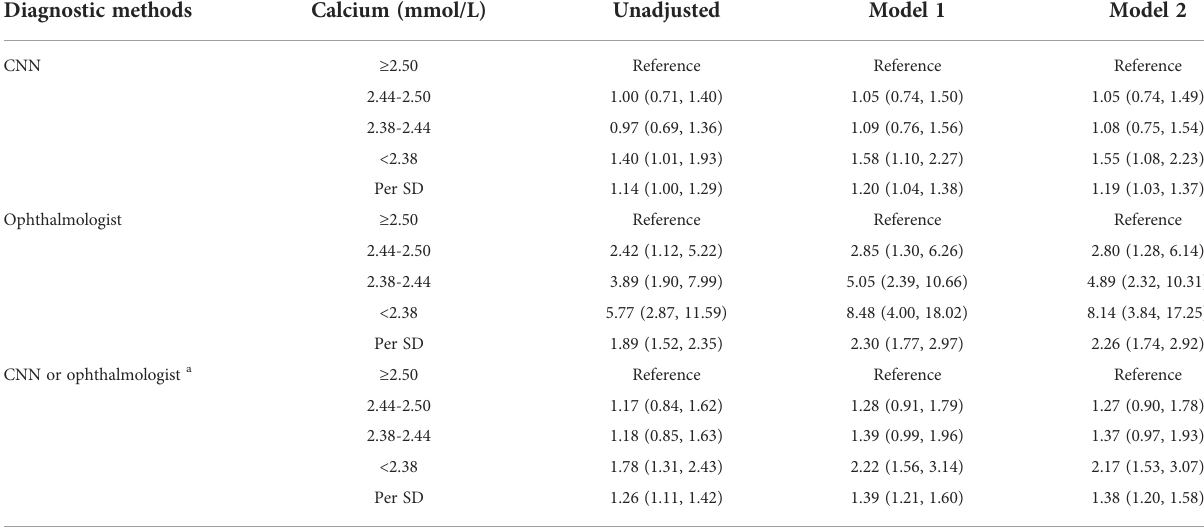
TABLE 2 Logistic regression analyses of serum calcium quartiles and per SD decrease with retinopathy.